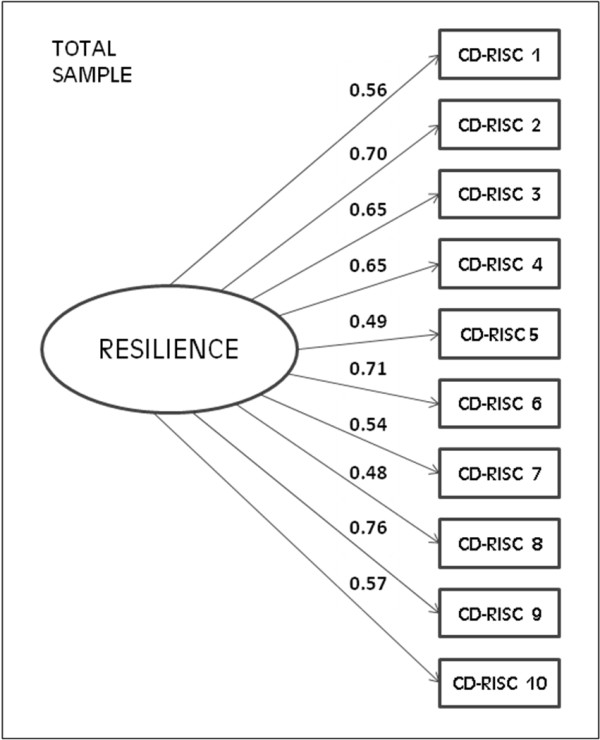
Factor loading and goodness-of-fit indexes of one-factor model for the 10-items CD-RISC factor structure. Total sample: n = 681; χ2 = 159.4, df = 35, p = 0.001, CFI = 0.94 and SRMR = 0.041.